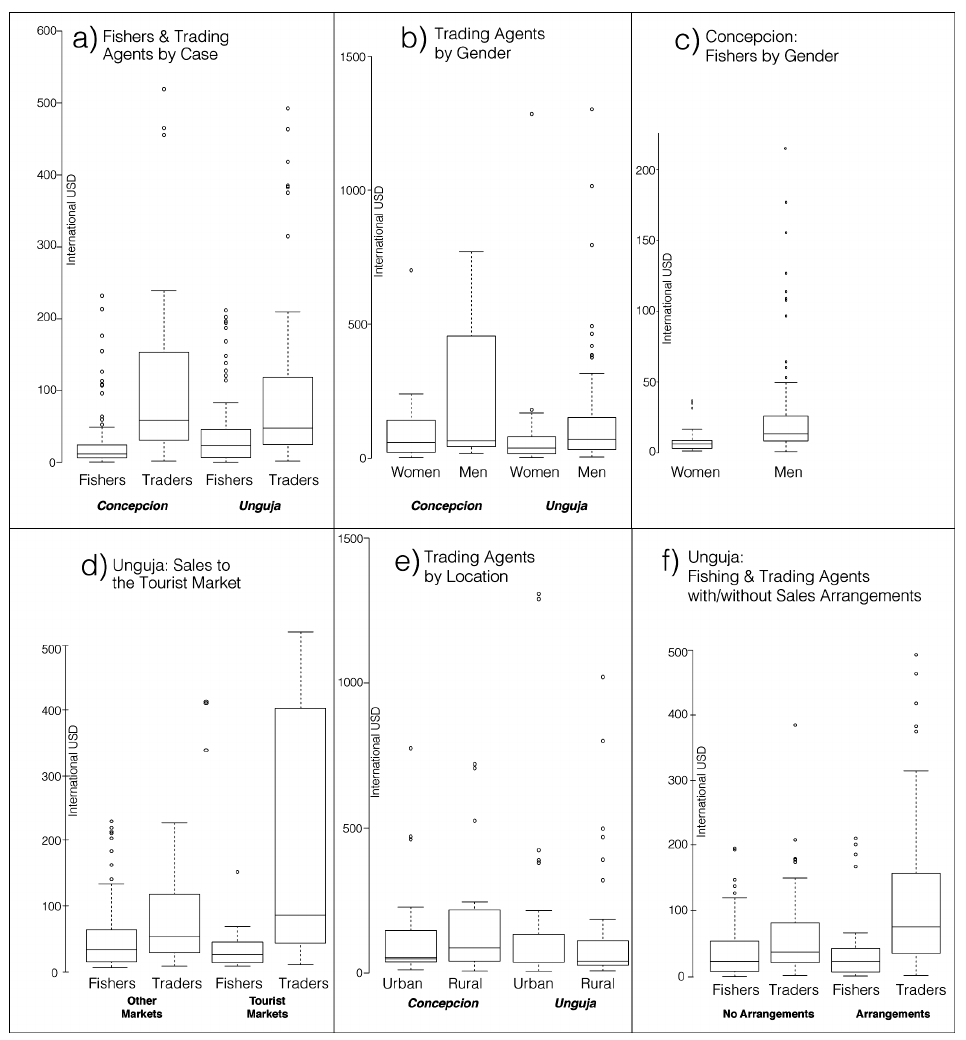
Fig. 4 . Box and whisker plots for income distributions across different nodes and groupings. Panels show differences in income between (a) fishers and trading in each site; (b) traders of different gender in each sites; (c) male and female fishers in Concepcion; (d) fishers and traders selling to hotels versus other markets; (e) rural and urban traders in both sites; and (f) fishers and traders with, and without, predetermined sales arrangements. Outliers are shown as small white circles. For graphical clarity outliers over US$500 were not included in (d) and (f) while those over US$550 were not included in (a). The line in the middle of the boxes represents the median, the end of the boxes show the upper and lower quartiles, the lines out from the boxes show the highest and lowest